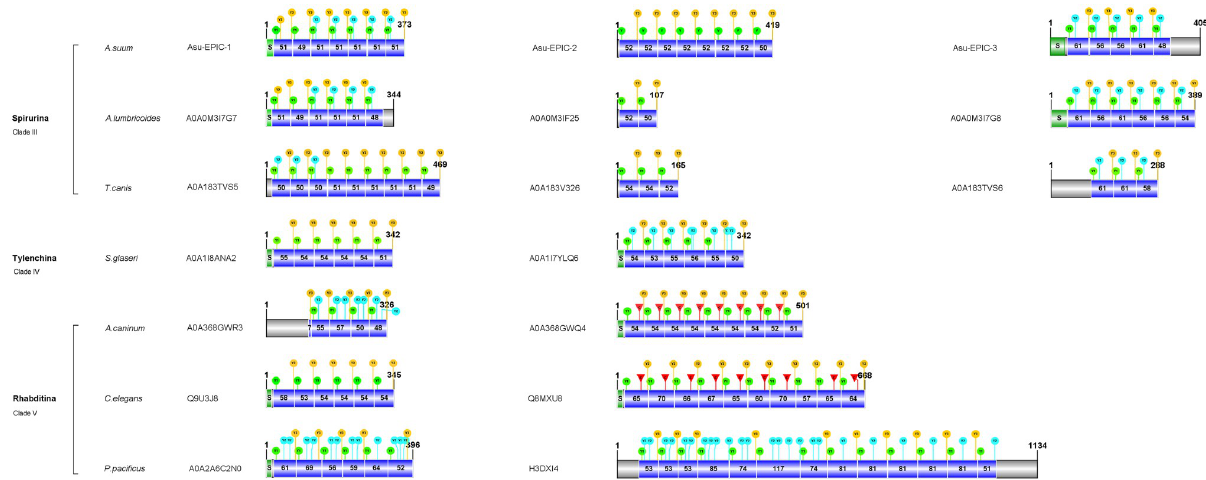
Fig 6. Comparison of the epicuticlins of seven nematode species belonging to three different clades. The sequences, with the Uniprot accession numbers, are drawn to scale, based on the number of amino acids, using IBS version 1.0.3 [47]. The different epicuticlin sequences of a given species are horizontally positioned. Signal peptide sequences (S) are shown as light green boxes. Repeats are represented as blue boxes in which the number of amino acids is given. Grey regions are non-repeat stretches. For each repeat, tyrosine residues are indicated with symbols (light green circles Y1 = Y GD; yellow circles Y3 = G Y R; the blue circles = Y2 indicate the additional tyrosine). Cysteine residues (red triangles C) are present in several epicuticlins of nematode species belonging to Clade V. Additional information is available in the S2 Table and deposited in the Dryad, Dataset, https://doi.org/10.